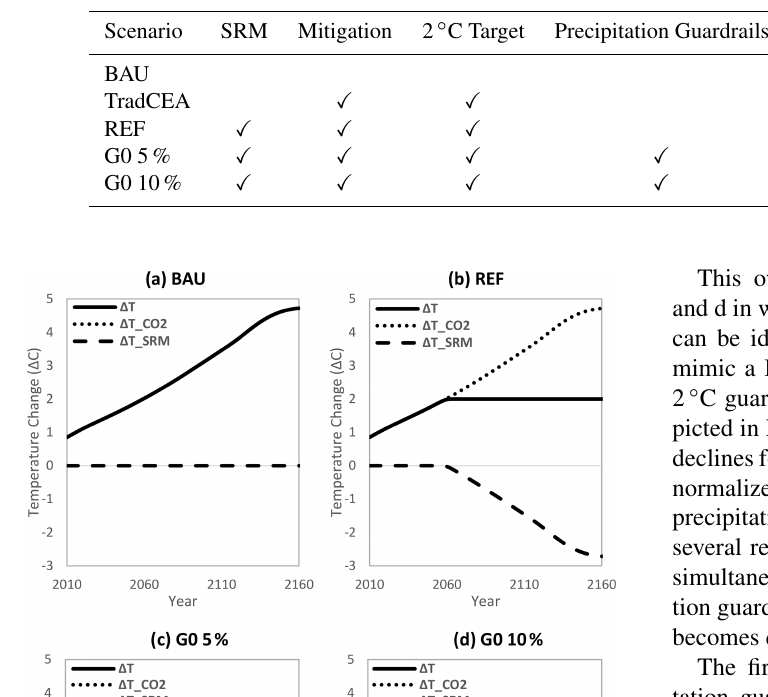
Table 2. Scenarios and their characteristics.